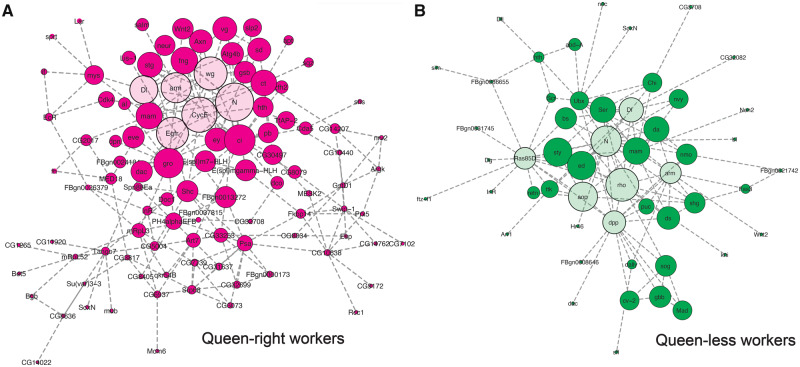
Network analysis identifies key hubs genes associated with differential enrichment of H3K27me. Genes with higher H3K27me3 enrichment in queen-right workers (magenta) (A) and queen-less workers (dark green) (B) are indicated by darker colored nodes. Interacting genes (queen-right workers, light magenta; queen-less workers, light green) were identified using BioGRID in DAVID. Network analysis was performed using Cytoscape. The predicted key hubs in this network have a high degree of centrality (as indicated by the relative size of each node) and are putative key regulators of reproductive constraint in honeybees.